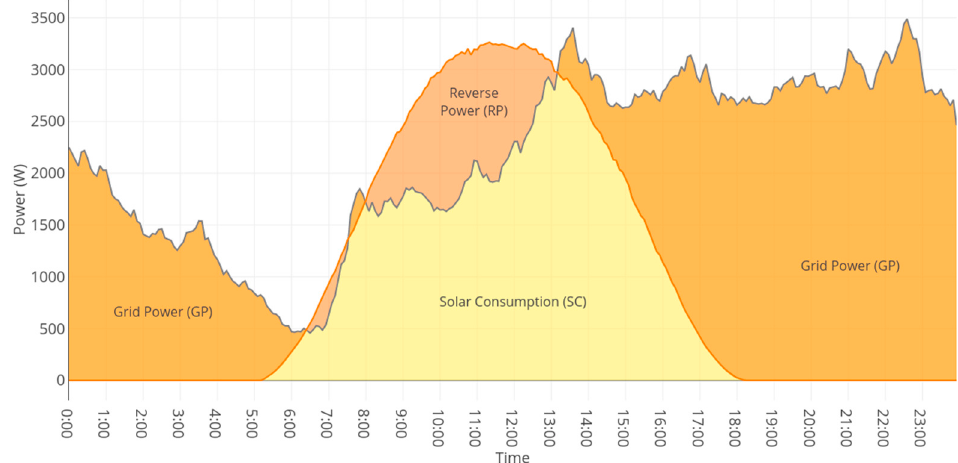
Figure 13. Total load power versus PV power production used for self-consumption ratio calculation.